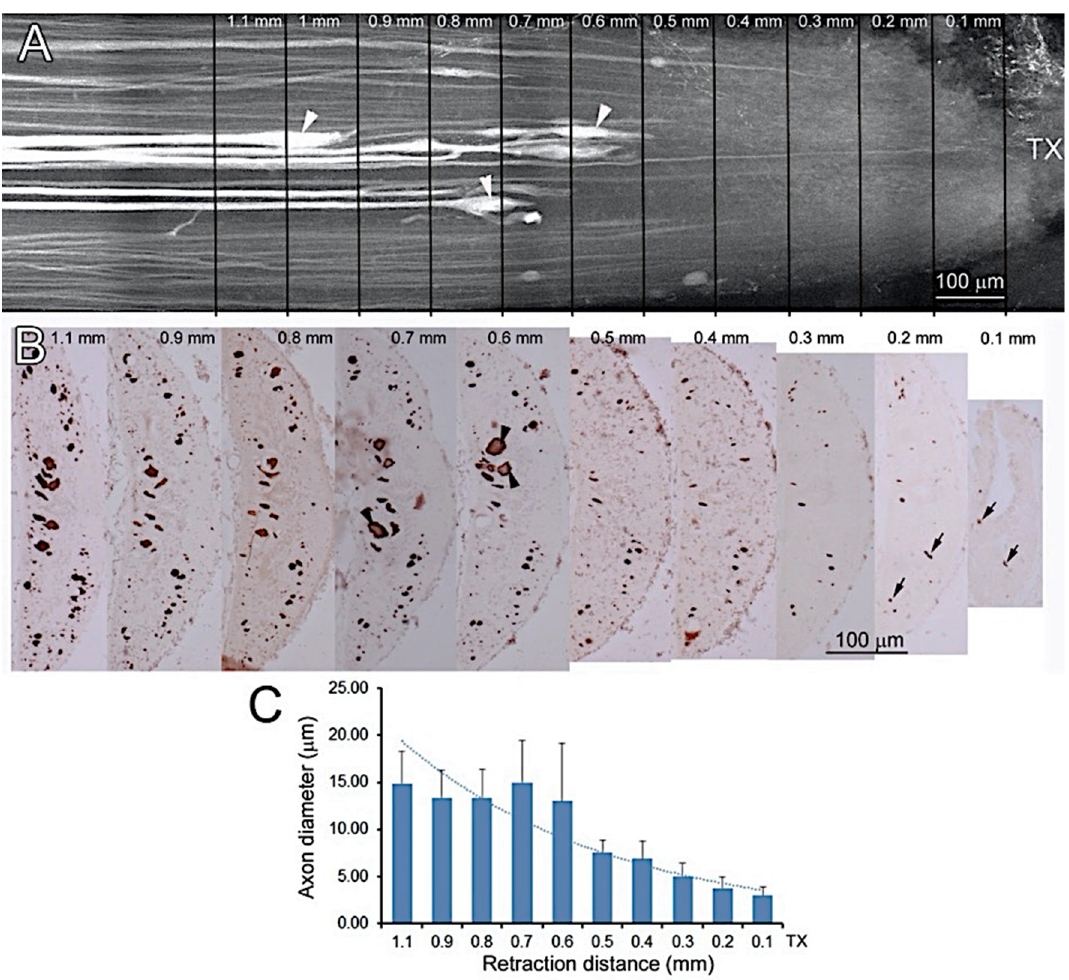
Figure 9. Small axons retract less and regrow through the TX earlier than large axons. At 2 weeks post-TX, axons were anterogradely labeled with DTMR and the SC was removed after only 24 h transport time. After BABB clearing, they were inspected by widefield fluorescence microscopy and processed for para ffi n sectioning and IHC. ( A ) Giant RS axons have retracted further and their terminal enlargements (arrowheads) can be seen more rostrally than small axons, even though small axons were not as e ffi cently filled with fluorecent dye. ( B ) serial transverse sections from the same sample as ( A ) stained with the anti-lamprey NF antibody LCM3. The distances from the TX site are marked by lines and numbers. Axons are stained brown. Several small axons remain near or in the TX site (black arrows), but the large ventromedially-located Müller axons (black arrowheads) have retracted rostrally at least 0.5 mm. ( C ) correlation of axon caliber with distance of retraction rostral from the TX site. The diameters of the 20 largest axons on a section were measured in every 10th section from the TX site to 1.1 mm rostrally. The largest-diameter axons have retracted far more than those of small caliber. Note that this procedure excludes some giant axons that have retracted even further than is visible, as well as the smallest axons. Note also that the diameters represent a 30% reduction from the living tissue, due to shrinkage by